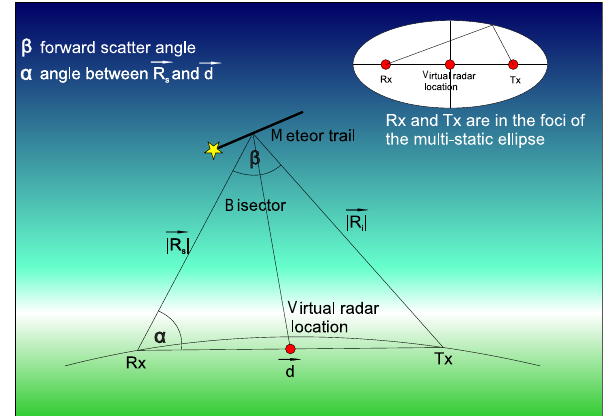
Figure 9. Schematic of a typical forward scatter meteor radar. The position of the Tx and Rx are known and all other parts are mea- sured. The Bragg vector k b always points towards the center of the direction vector d